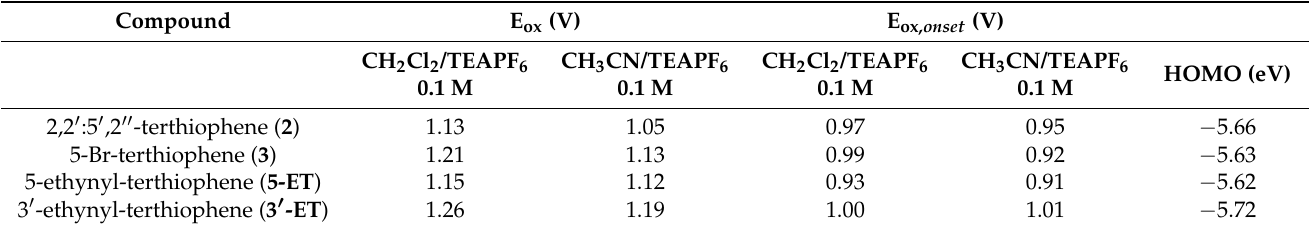
Table 1. Electrochemical data of the terthiophene derivatives in CH 3 CN/0.1 M TEAPF 6